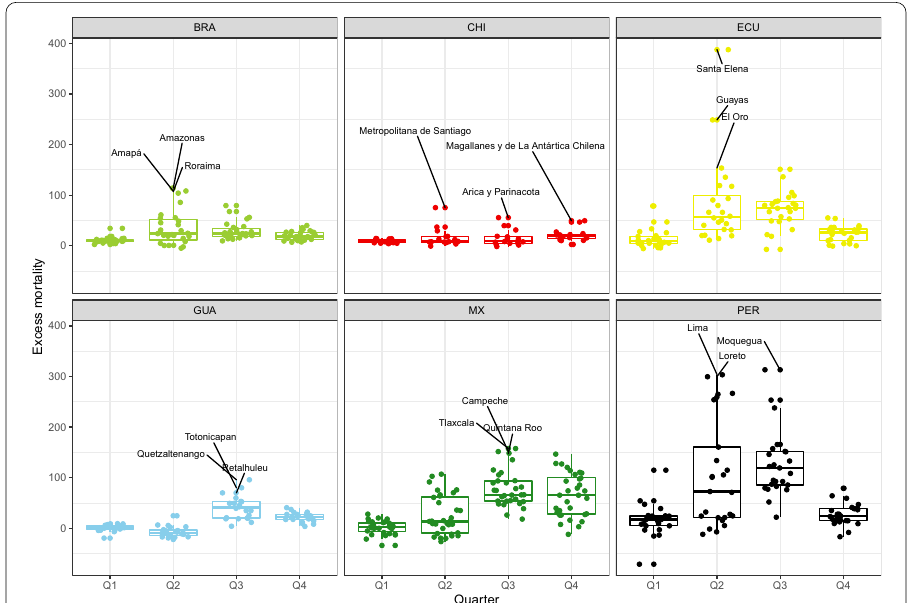
Fig. 2 Distribution of excess mortality during the COVID‑19 pandemic: deaths from all causes compared to previous years, all ages in selected countries and regions of Latin America in 2020. Source: Ministry of Health, Brazil, Chile, and Peru, 2021; National Civil Registry Ecuador (Gobierno de la República del Ecuador, 2021); National Registry of Persons Guatemala (RENAP, 2021); and Secretariat of Health, Mexico (DGE‑SS, 2021). Names and acronyms of countries are presented in Additional file 4: Table